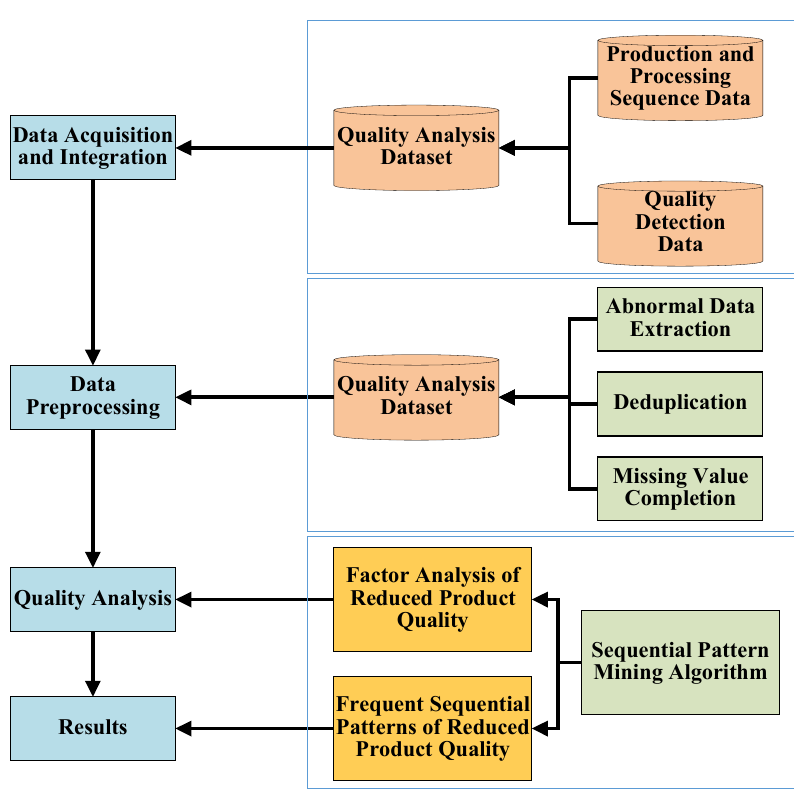
Figure 1. Product quality analysis process based on manufacturing data.